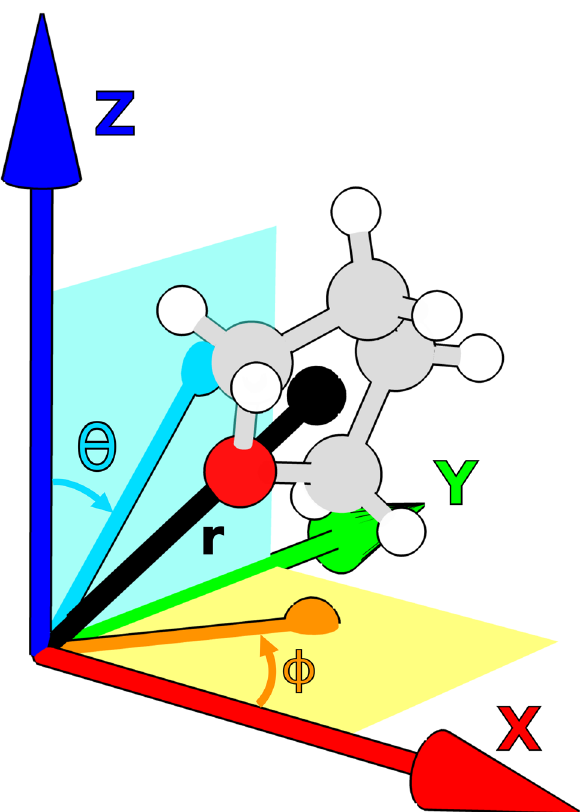
Figure 5. Spherical coordinates representing the position of a ligand in the coordination space. The barycenter of the ligand is represented as a black sphere, and its position vector as the line extending from the origin to the sphere. Position in the coordination ray is represented by the radial coordinate r , defined as the distance from the barycenter to the origin. The inclination θ is defined as the angle between the Z axis and the projection of the barycenter position vector into the ZY plane, shown in dark cyan. The azimuth φ is defined as the angle between the projection of the barycenter position vector in the XY plane and the X